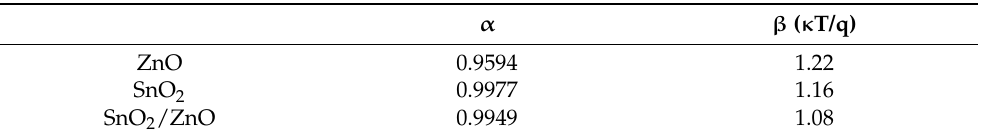
Table 4. The values of the light intensity dependence of J SC and V OC of the device with different cathode buffer